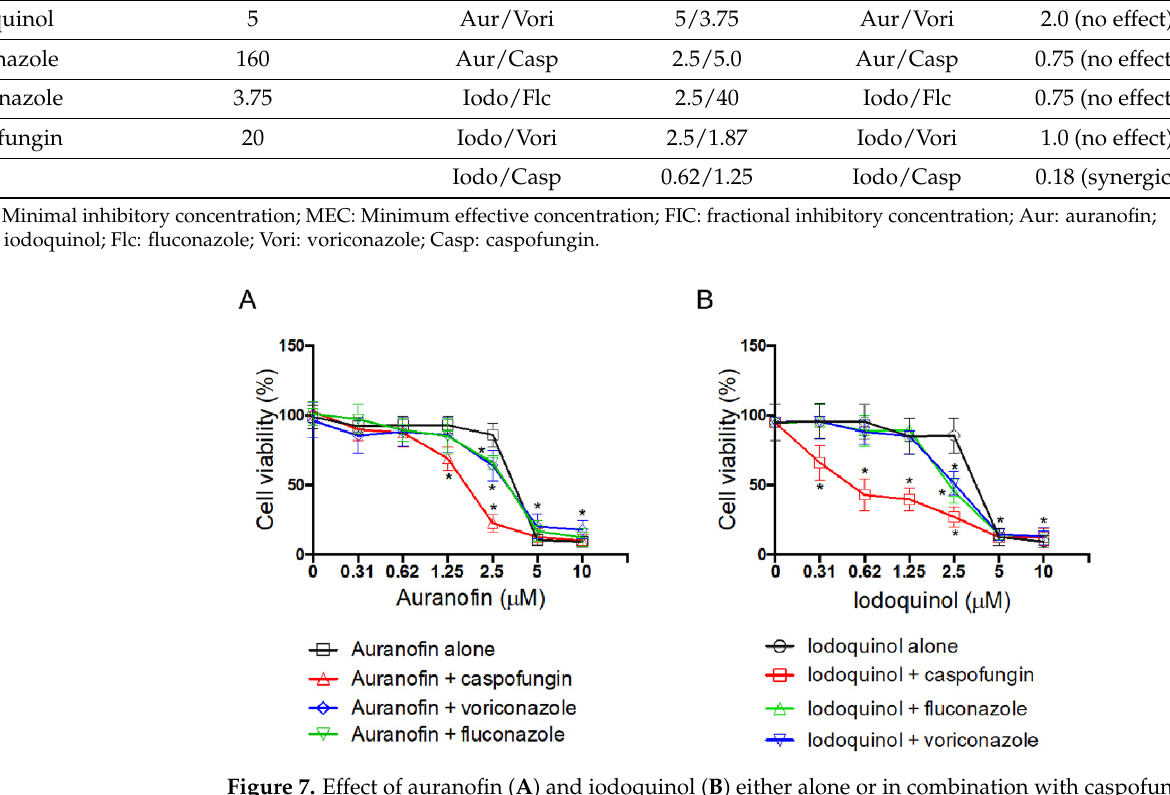
Figure 7. Effect of auranofin ( A ) and iodoquinol ( B ) either alone or in combination with caspofungin, fluconazole and voriconazole against S. aurantiacum CBS 136046. Viability was measured using XTT-reduction assay after 72 h of incubation. * p < 0.01.